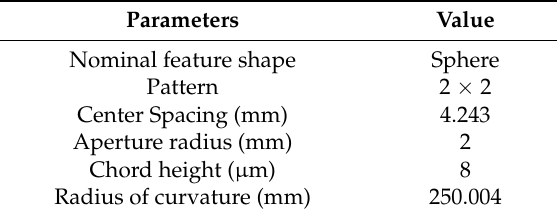
Table 4. Micro-lens array (MLA) design parameters.